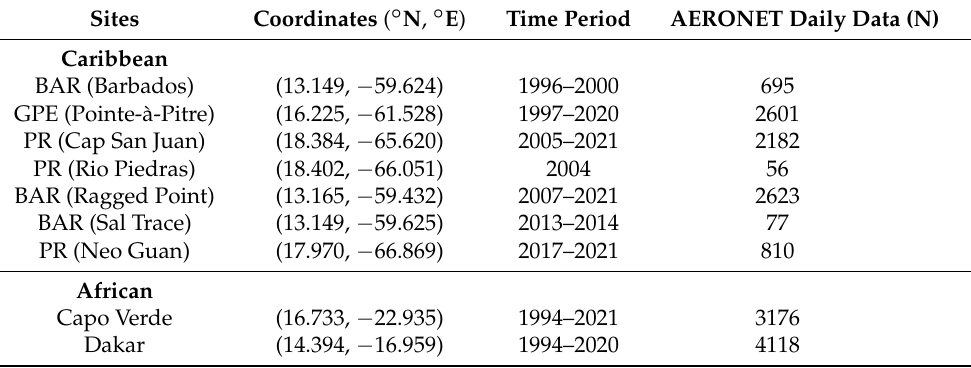
Table 1. Geographical coordinates, considered periods, and total number (N) of daily AERONET data used for Caribbean sites (PR, GPE, and BAR) and African sites (Capo Verde and Dakar). Sites Coordinates ( ◦ N , ◦ E ) Time